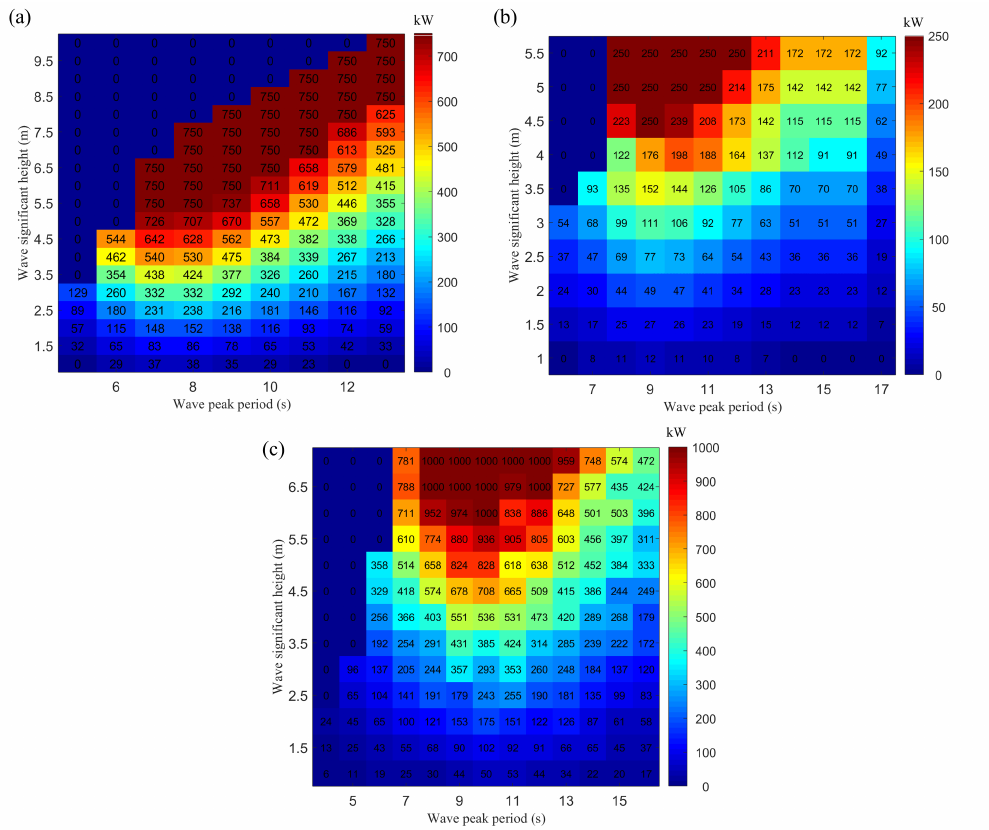
Figure 12. Power matrices of the investigated wave energy converters ( a ) Pelamis. ( b ) AquaBuoy. ( c )